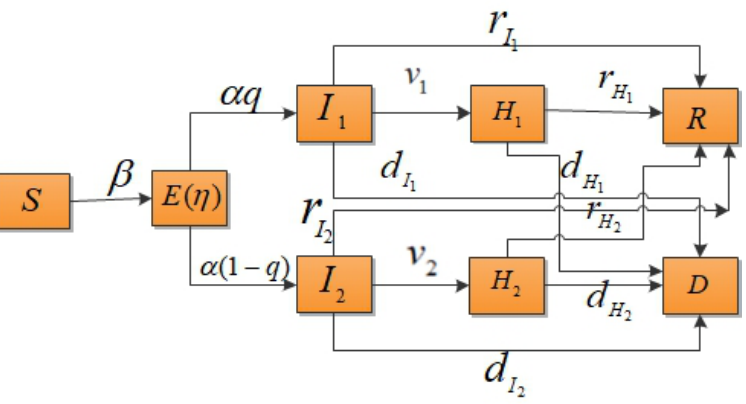
Figure 1. Compartment model of infectious disease transmission considering the isolation of hospi- talized mildly and severely infected